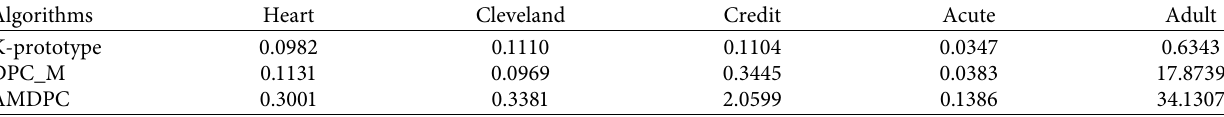
Table 10: Running time of the K-prototype, DPC_M, and proposed AMDPC in different datasets. Algorithms